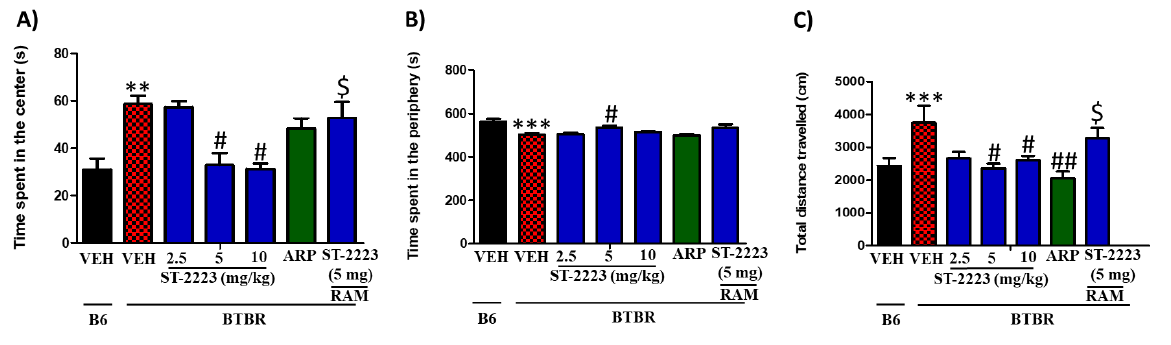
Figure 3. Effects of ST − 2223 on anxiety-like behaviors and locomotor activity of B6 and BTBR mice in open field test. Time spent in the Center ( A ). Time spent in the periphery ( B ). Total distance travelled ( C ). ** p < 0.01 compared to VEH-treated B6 mice. *** p < 0.001 compared to VEH-treated B6 mice. # p < 0.05 compared to VEH-treated BTBR mice. ## p < 0.01 compared to VEH-treated BTBR mice. $ p < 0.05 compared to ST − 2223 − (5 mg)- treated BTBR mice. Data are expressed as the mean ± SEM (n = 5).